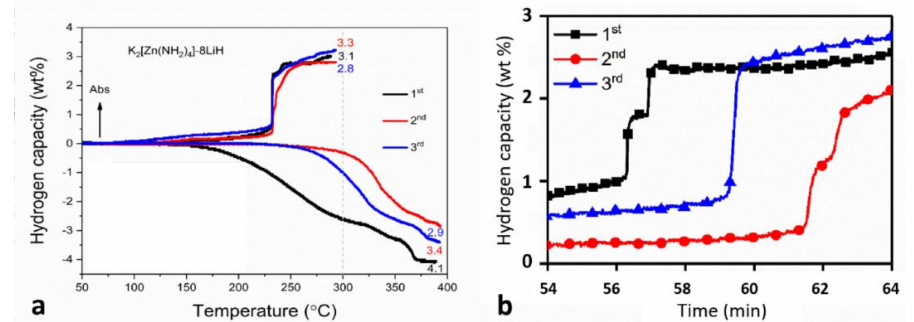
Figure 7. Volumetric desorption and absorption cycles of the K 2 [Zn(NH 2 ) 4 ] + 8LiH system vs. temperature ( a ) and time ( b ). The desorption step has been performed from room temperature to 400 ◦ C (3 ◦ C/min) under static vacuum while the absorption from room temperature to 300 ◦ C (3 ◦ C/min) under 50 bar H 2 . [147].